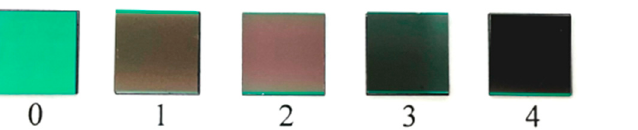
Figure 1. Thin films sputtered on oxidized Si substrates: ( 1 ) SWCNT, ( 2 ) MWCNT, ( 3 ) SWCNT/rGO, ( 4 ) MWCNT/rGO compared to ( 0 ) pure oxidized Si.